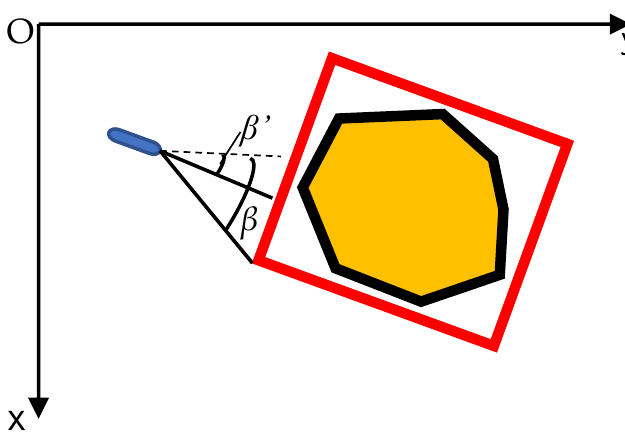
Figure 3. Avoid static obstacles.